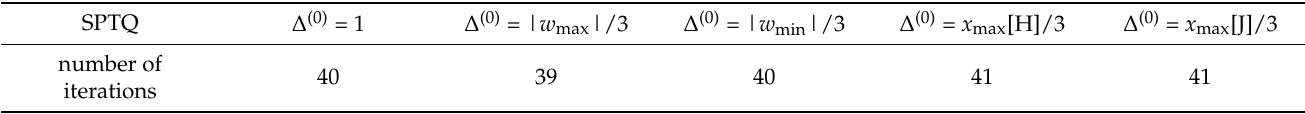
Table 2. Number of iterations for determining x maxSPTQ for different